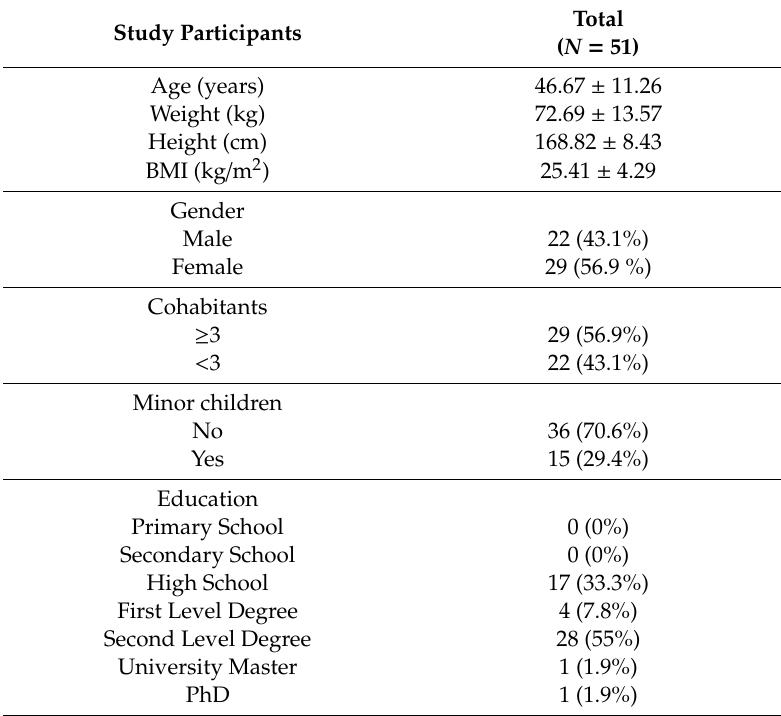
Table 1. Study population